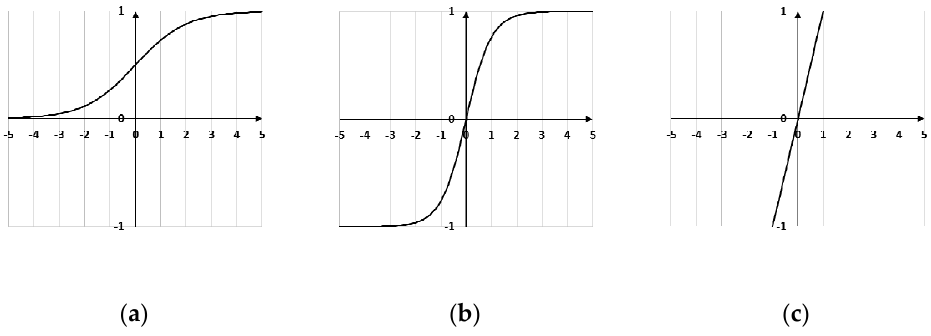
Figure 3. Types of activation functions. ( a ) Logsig. ( b ) Tansig. ( c ) Purelin.